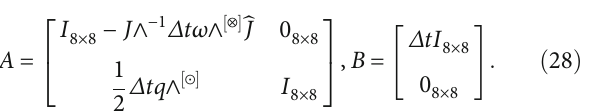
Table 3: MPC system